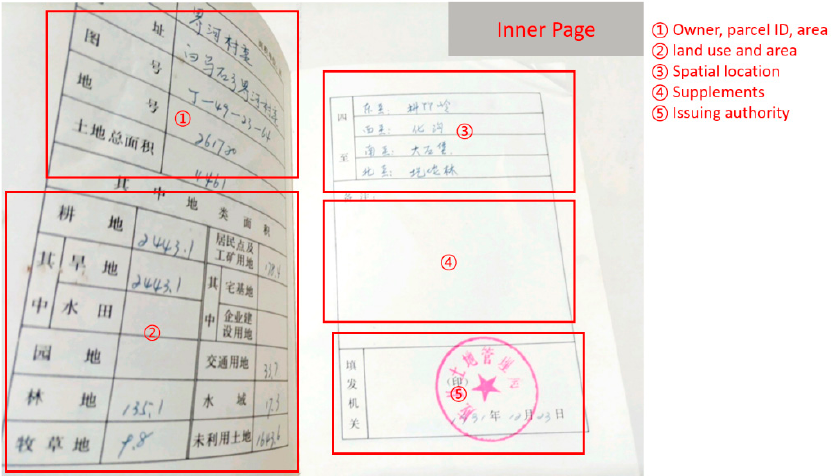
Figure 4. Certificate of collective land ownership (source: https://pic17.997788.com/_pic_search/00/27/06/15/27061537b.jpg, accessed on 26 October 2021 ).